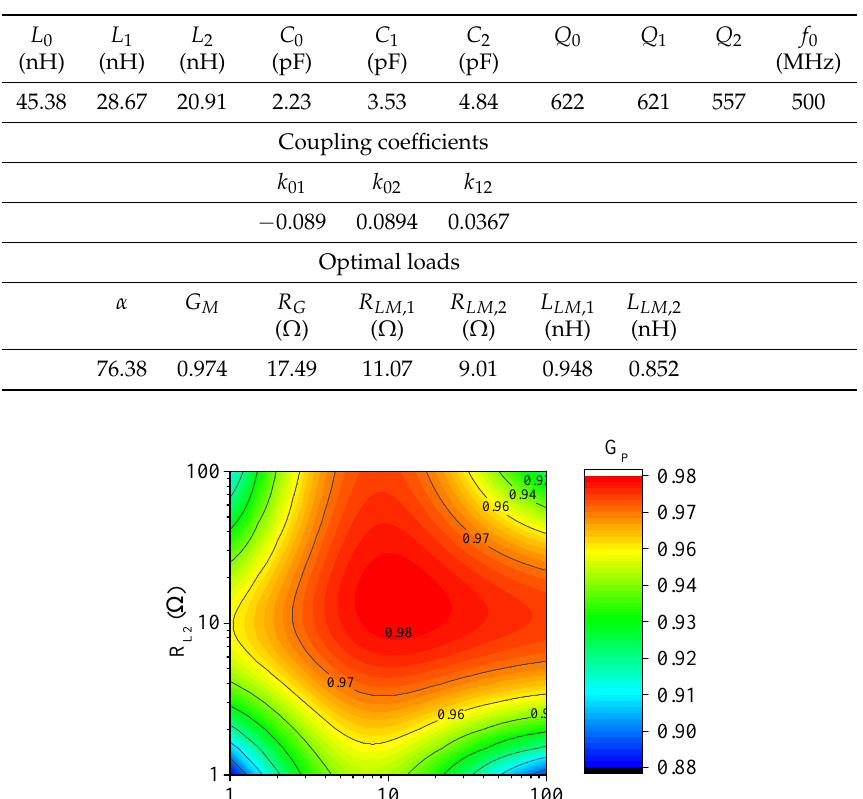
Figure 9. Case 4: WPT link analyzed through full-wave simulations. The link has a single transmitter and two receivers. Table 4. Parameters of the equivalent circuit and optimal loads of the WPT link illustrated in Figure 9 (Case 4).